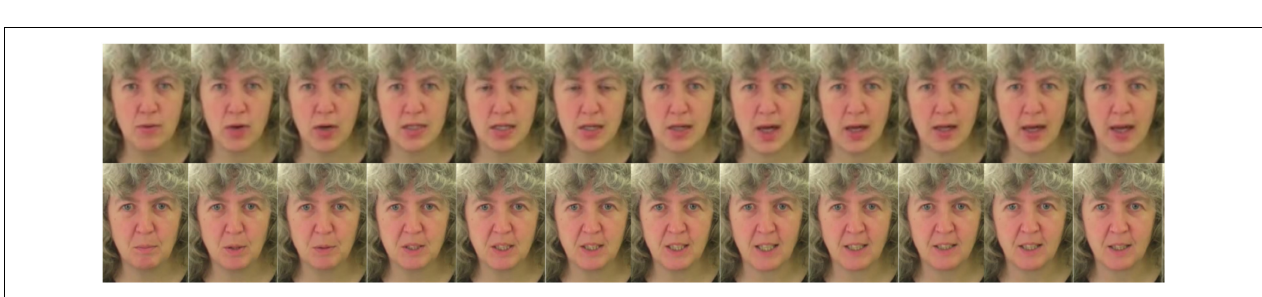
FIGURE 3 | An example of frames from a generated video (top row) shown alongside the corresponding real video (bottom row). Source: adapted from the GRID corpus (available at: https://doi.org/10.5281/zenodo.3625687) under CC-BY 4.0